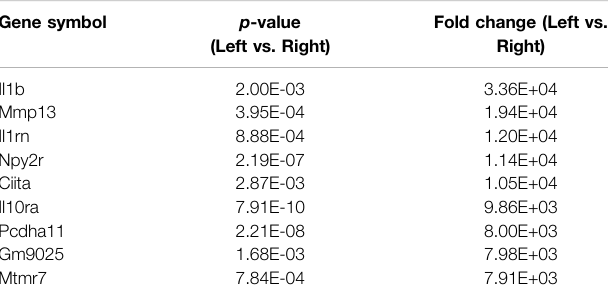
TABLE 1 | Top ten most upregulated genes. The top ten most upregulated genes are listed here with their corresponding p -values and fold changes from RNAseq results.